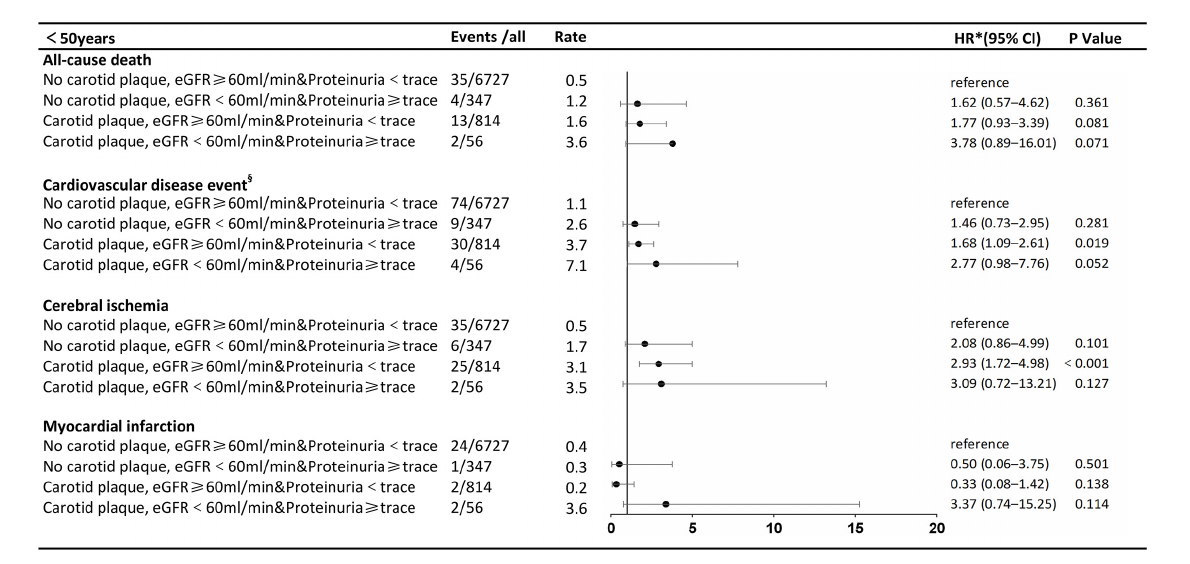
FIGURE3 Association of carotid plaque and renal impairment with all-cause death and cardiovascular disease events in subgroups stratified according to age. § Cerebral ischemia or myocardial infarction. *The model was adjusted for age, sex, smoking, alcohol, body mass index, fasting blood